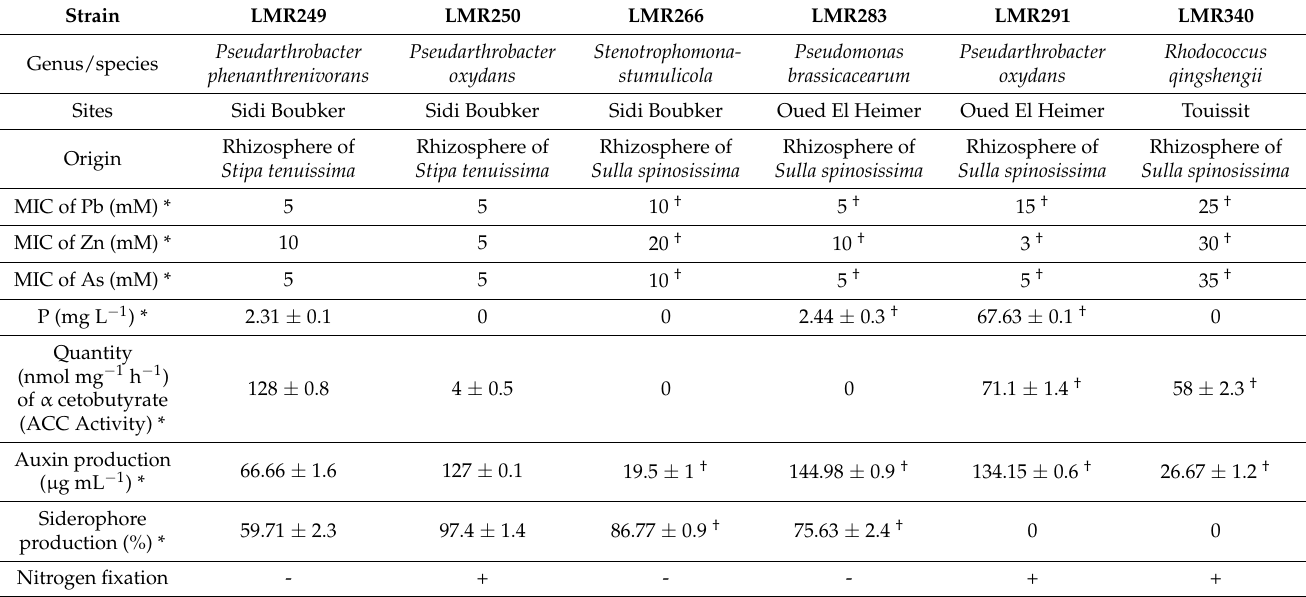
Table 1. Heavy metal tolerance and plant growth-promoting traits of bacterial isolates under in vitro